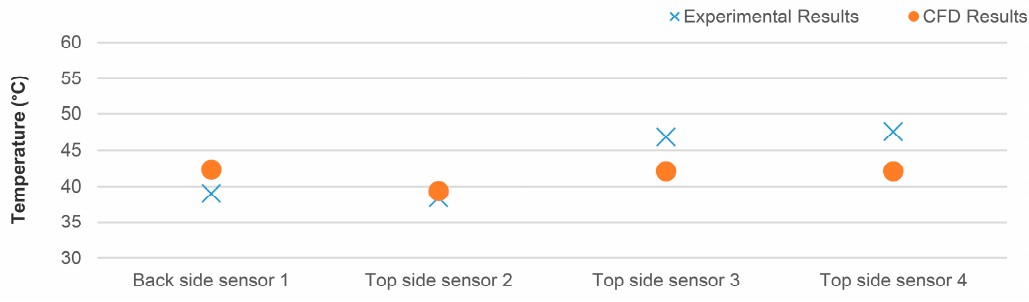
Figure 16. Measurement C: experimental results versus CFD results . Figures 14, 15 and 16 show a reasonable fit between the experimental and the CFD results, as the deviation from the CFD model varies from 0.2% up to 11.4%. The average deviation value for four sensors is 7%. 3.3. CFD Results The validation of the model allows further analysis of the CFD results. Figure 17 shows the distribution of incident total radiation in the collector for a tilt angle of 30°, as in measurement A,